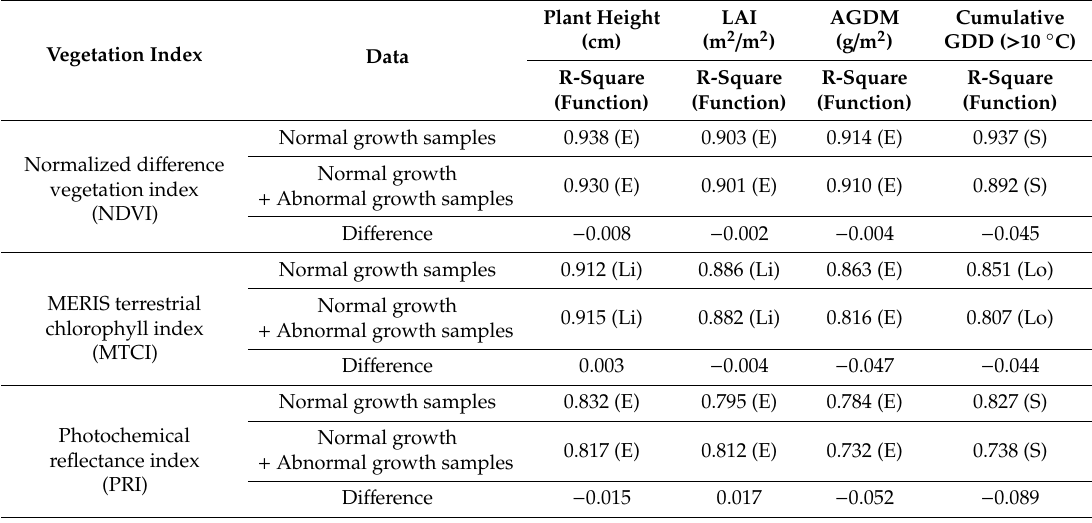
Table 3. The relationship between vegetation indices and cumulative growing degree days (GDD), plant height, leaf area index (LAI) or above-ground dry matter (AGDM) before the heading stage. Di ff erence indicates the di ff erence of R-square between “normal growth samples” and “normal growth + abnormal growth samples”. Li, Lo, S, and E are abbreviations for linear, logarithm, Sigmoid, and exponential function ( p -value <